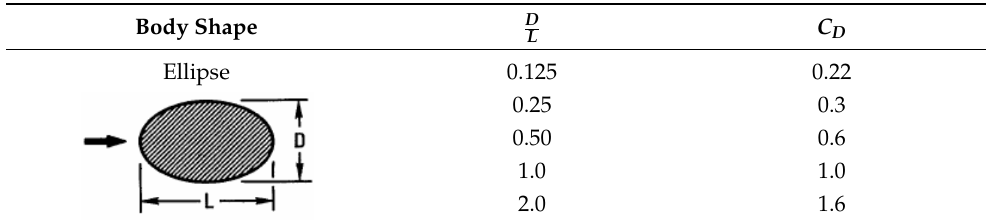
Table A6. Drag coefficients for the flow normal to the infinitely long ellipse (reproduced from [48], with permission from DNV, 2021).